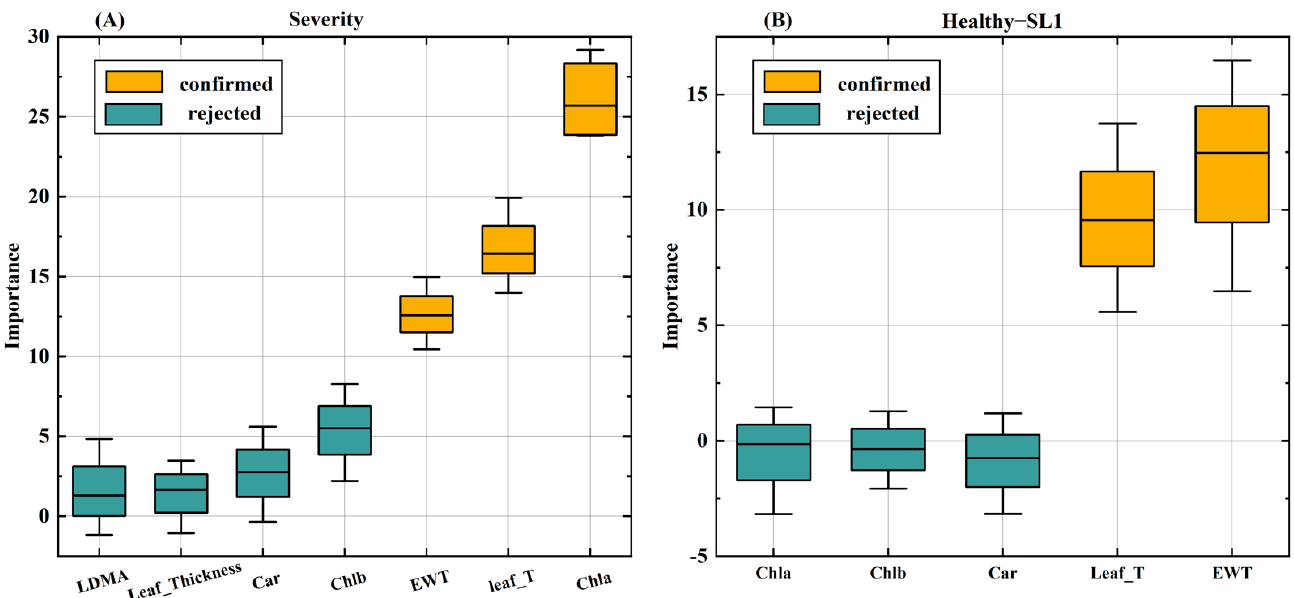
Figure 5. Multiple ‘symptom’ feature selection based on Boruta’s algorithm. ( A ) Selection of ‘symp- tom’ features for different VW severities in cotton leaves; ( B ) selection of ‘symptom’ features for healthy and mildly affected stages.